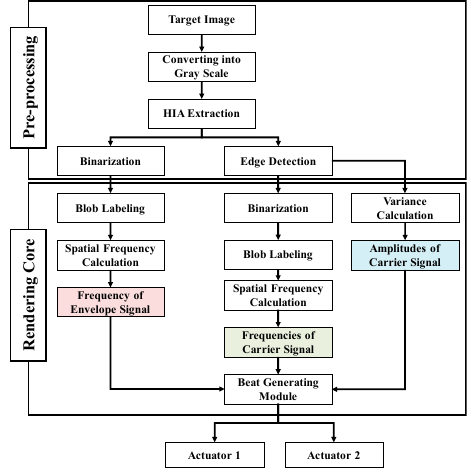
Figure 2. Procedure for the proposed rendering method.